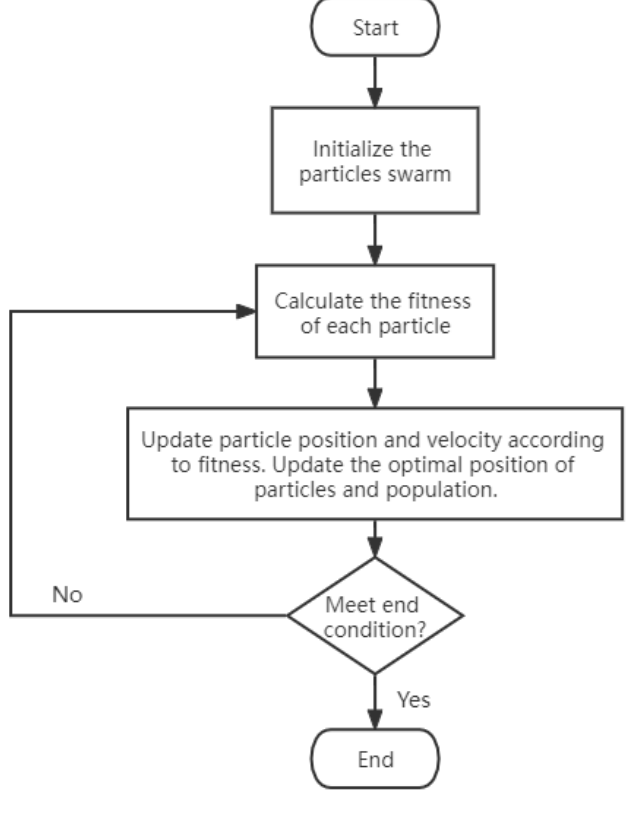
Figure 3. The flow chart of